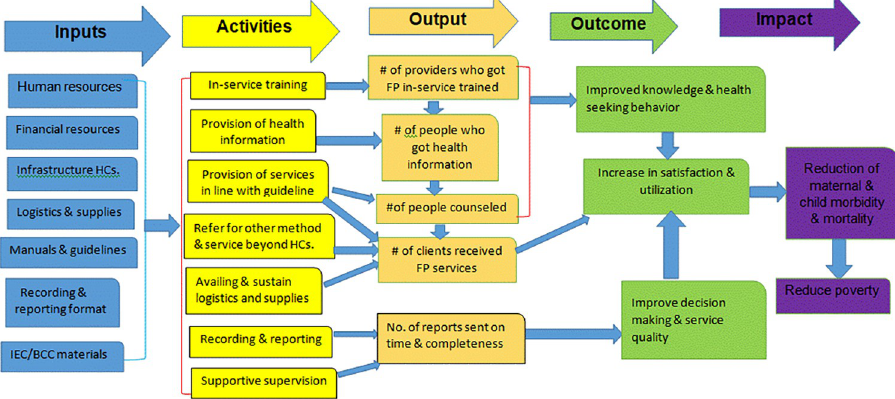
Fig 1. Logic model of family planning service delivery in Gondar city administration public health facilities, Northwest Ethiopia, 2020.